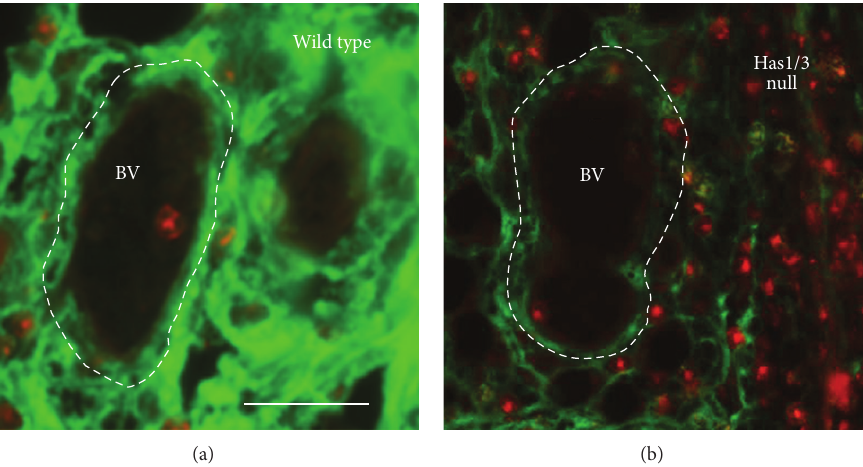
Figure 1: Skin biopsies from a wound edge at 24 h after wounding. Specimens from (a) normal mice ( wild type ) or (b) knockout mice lacking the genes for HAS1 and HAS3 ( Has1/3 null ) were stained with an HA binding probe to visualize HA (green) and an anti-myeloperoxidase antibody to visualize neutrophils (red). Note the marked loss of HA and increase in neutrophils extravasating from the blood vessel (BV) in the HAS1/3 deficient skin. Bar, 50 𝜇 m. From [50], used with permission